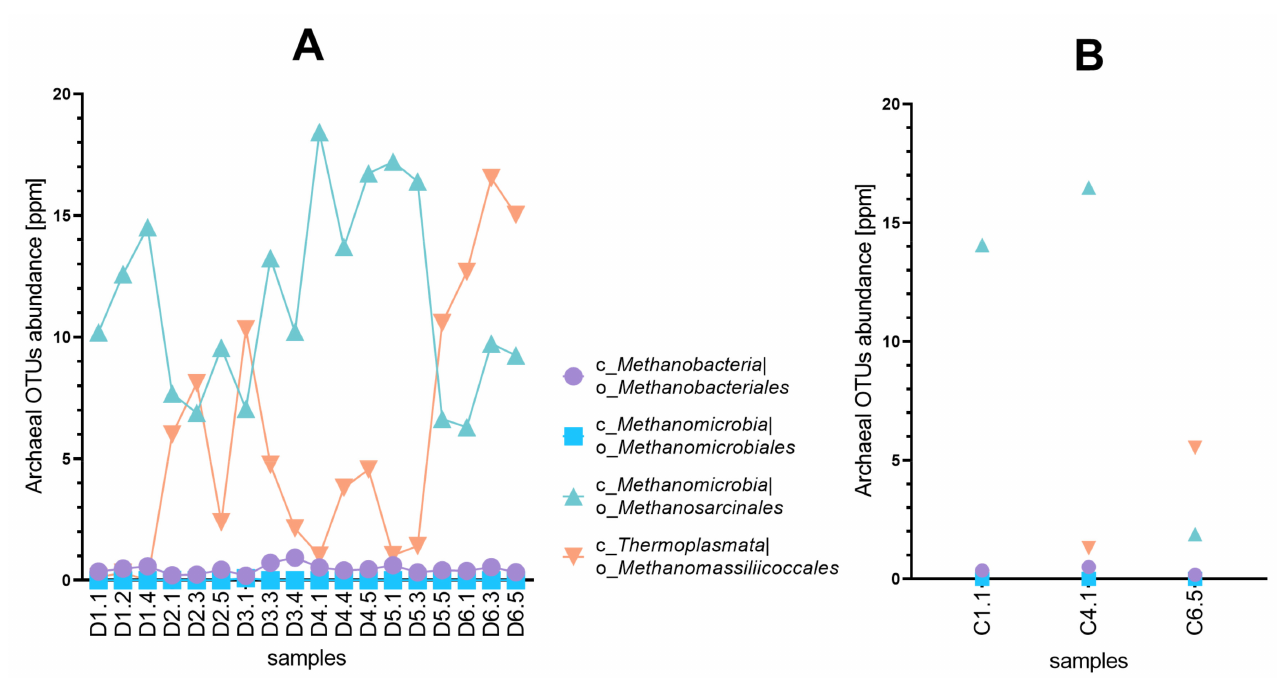
Figure 5. Abundance of OTUs [ppm] characteristic of different orders of the kingdom Archaea in the process ( A ) and control bioreactors ( B ). D—dose ID, C—control